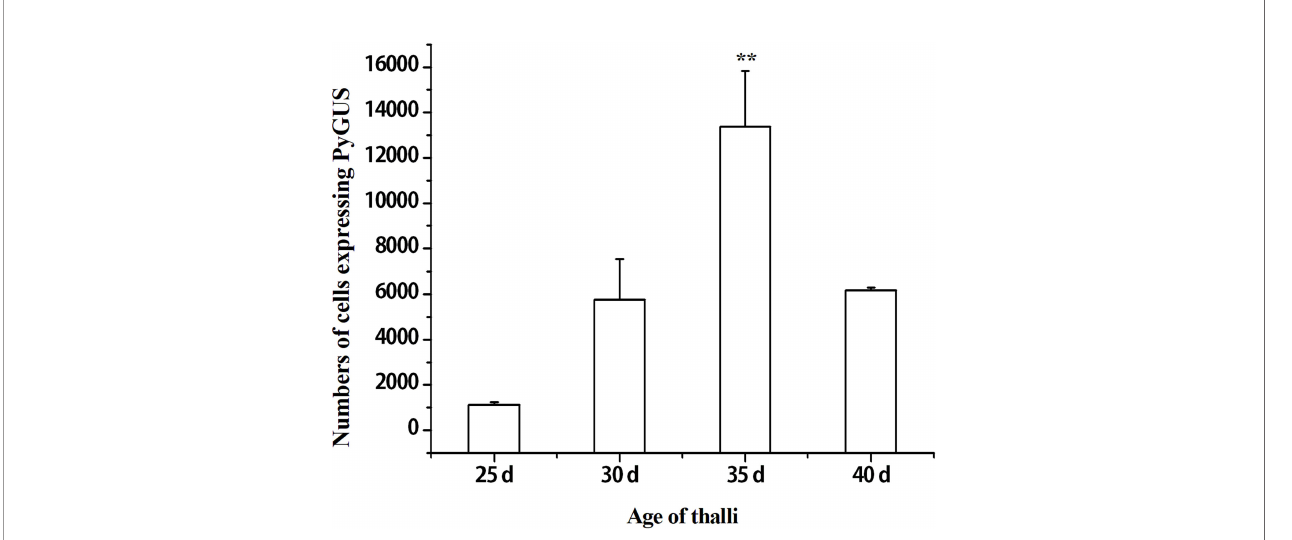
FIGURE 1 | Effects of different thalli ages on the number of cells expressing PyGUS in N. yezoensis . The thalli age of 25, 30, 35, and 40 days correspond to the time after conchospores release. Data are expressed as mean ± SD ( n = 3). **P < 0.01 by analysis of